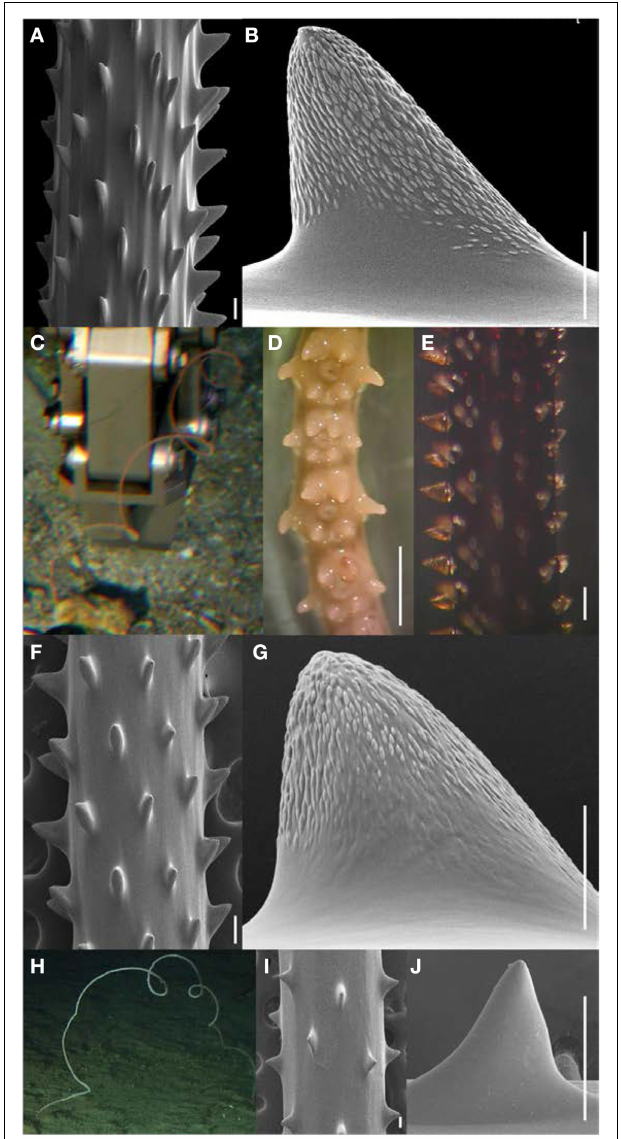
FIGURE 4 | (A,B) Skeletal spines of Stichopathes echinulata holotype (USNM 100371) under SEM (scale bars = 100 μ m). (C–G) Hawaiian S. echinulata colonies c. in situ ; (D) preserved polyps under light microscopy (scale bar = 1mm); (E) skeletal spines under light microscopy (scale bar = 200 μ m); (F) skeletal spines under SEM (scale bars = 100 μ m); and (G) close-up of polypar spine under SEM (scale bar = 50 μ m). (H–J) Hawaiian Stichopathes sp. with white tissues (H) in situ ; (I,J) Skeletal spines under SEM (scale bars = 100 μ m). ( C,H Photos courtesy of